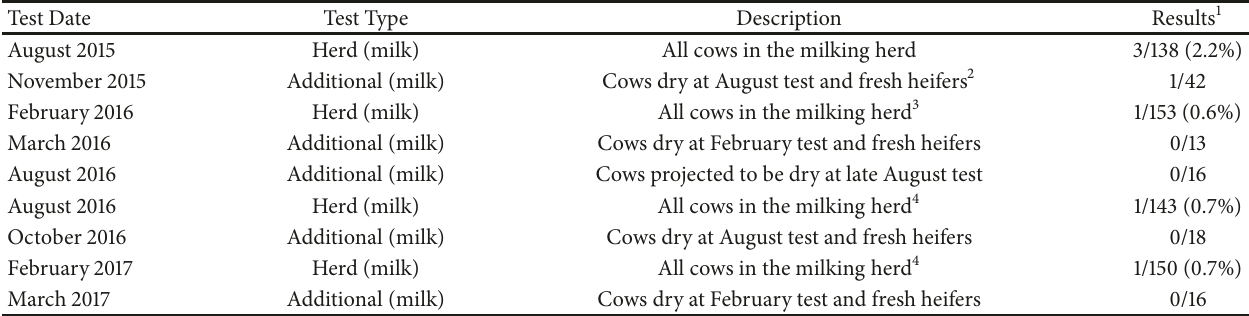
Table 1: Bovine leukemia virus (BLV) antibody testing schedule and results for Herd